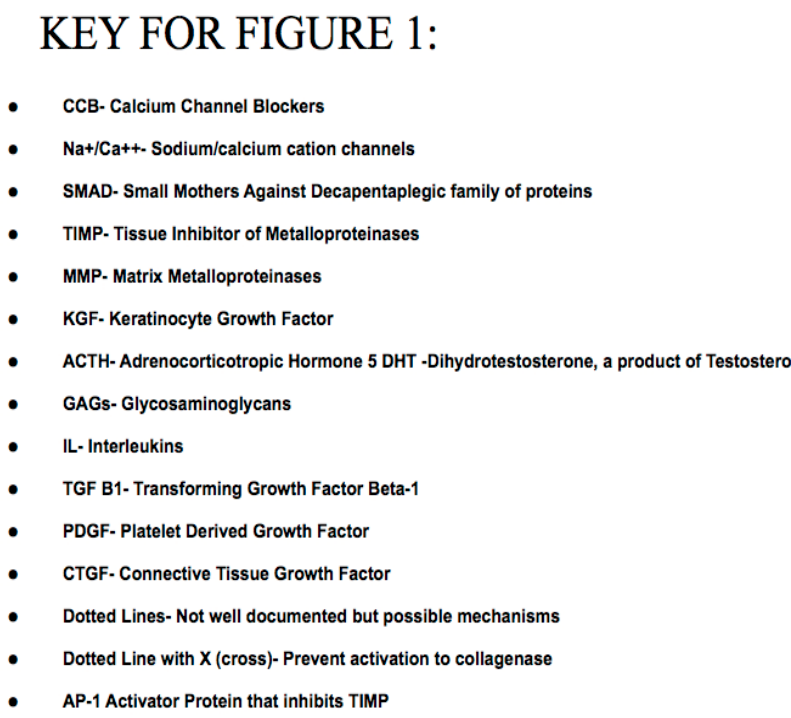
Figure 1. Possible mechanisms of CCB influenced gingival overgrowth.